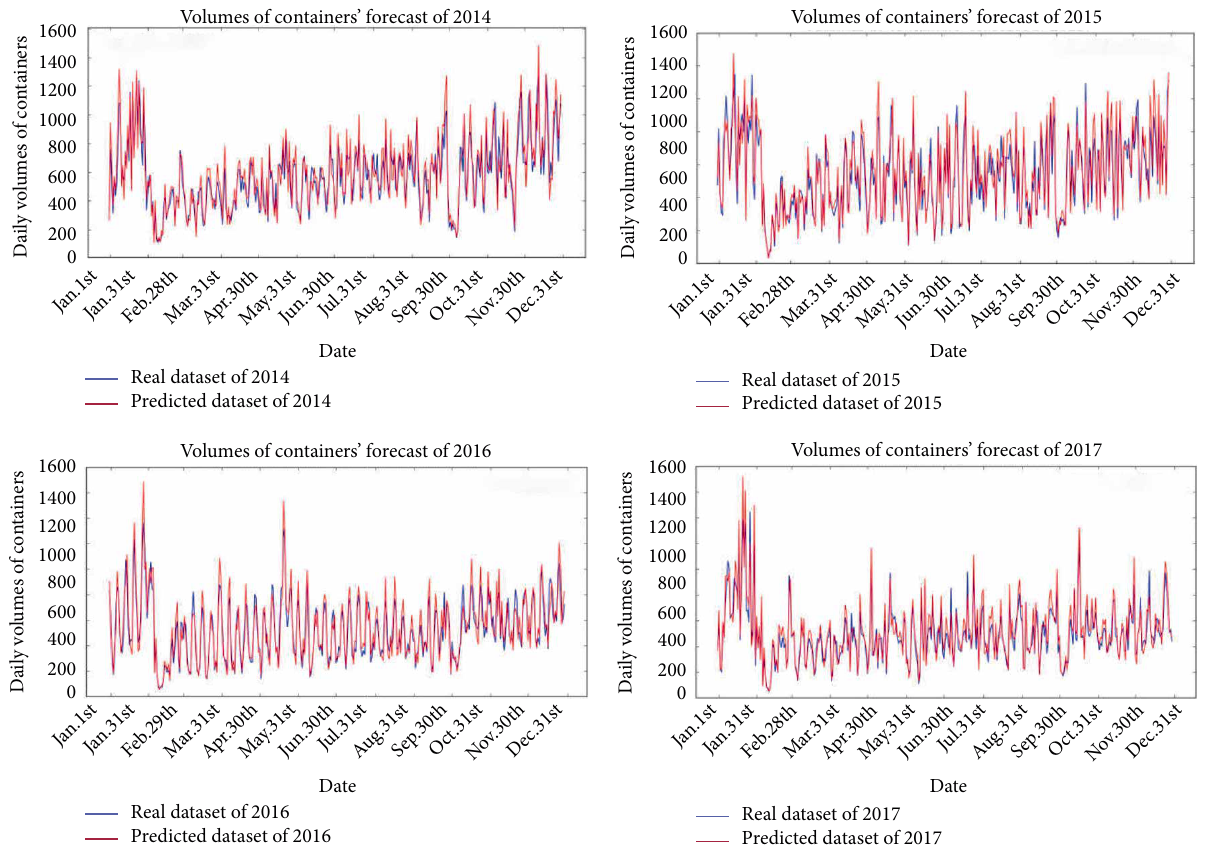
Figure 8: The prediction results with ARIMA